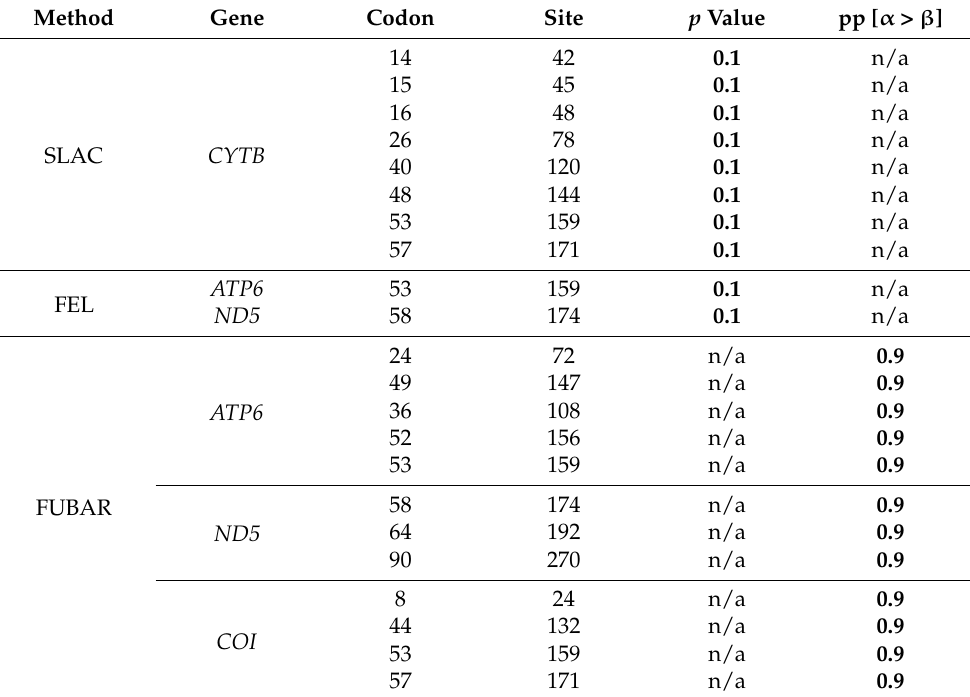
Table 4. Phylogenetic inferences on episodic or pervasive historical events of selection and adopting three different algorithms.